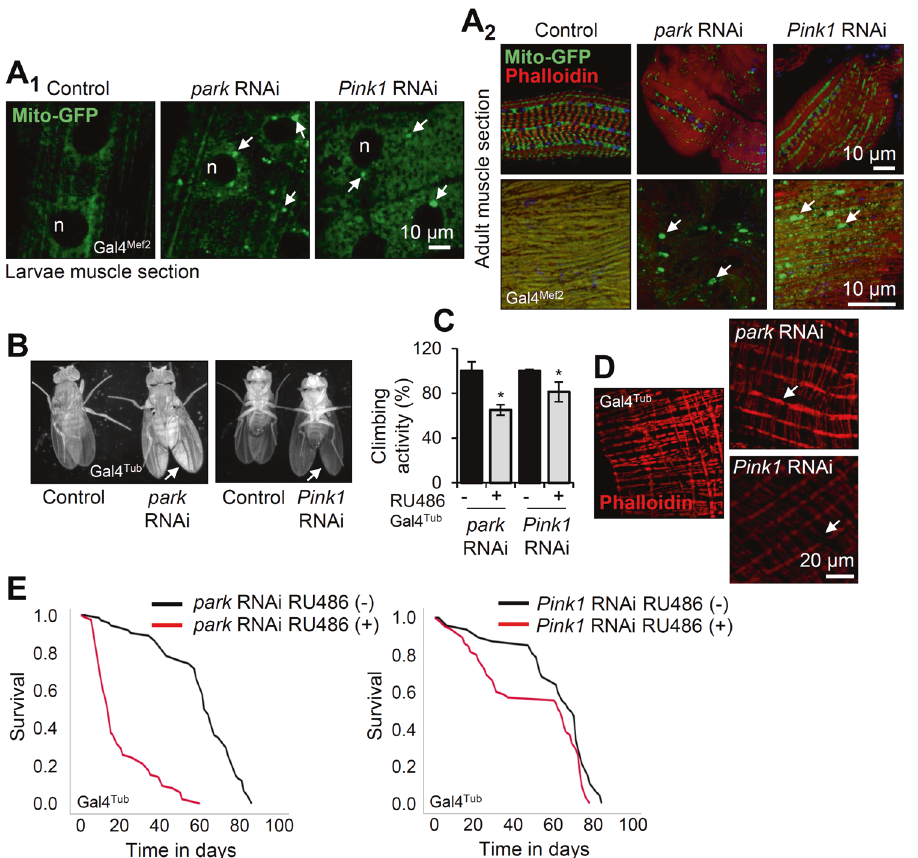
Fig. 2 Expression of park or Pink1 RNAi accelerates degenerative age-related phenotypes in transgenic fl ies. A CLSM visualization of muscle mitochondria after muscle targeted (Gal4 Mef2 ) KD of park or Pink1 genes in larvae ( A 1 ) and adult fl ies ( A 2 ) muscles; Mito-GFP was used to visualize mitochondria, phalloidin (red) for muscle actin and DAPI (blue) for cell nuclei. B Light stereoscope imaging of wing posture in control [RU486 ( − )], park and Pink1 RNAi expressing fl ies. C Relative locomotion (climbing) activity of 25 days old fl ies of the shown genotypes after ubiquitous (Gal4 Tub ) Tg expression. D Intestine muscle staining with phalloidin (red) after park or Pink1 muscle targeted (Gal4 Mef2 ) KD. E Longevity curves of the shown transgenic fl y lines after ubiquitous (Gal4 Tub ) park or Pink1 KD. Log-rank, Mantel-Cox test: control vs. park RNAi P < 0.0001, control vs. Pink1 RNAi P < 0.01. Statistics of the longevity curves are also reported in Supplemental Table S1. Flies were exposed to 320 μ M RU486 for 25 days, except otherwise indicated. Bars, ±SD; n = 3, * P <